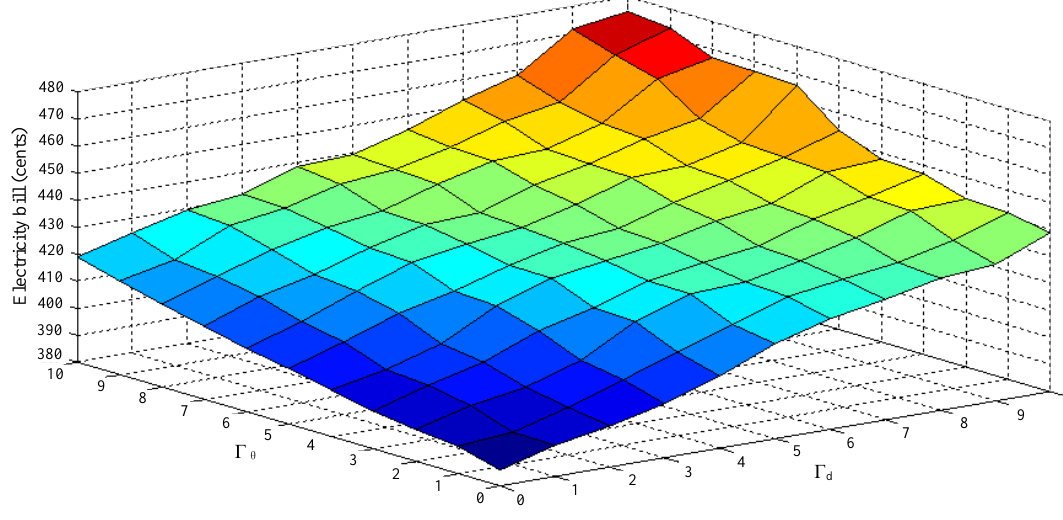
Figure 7. The electricity bill under different robust levels.